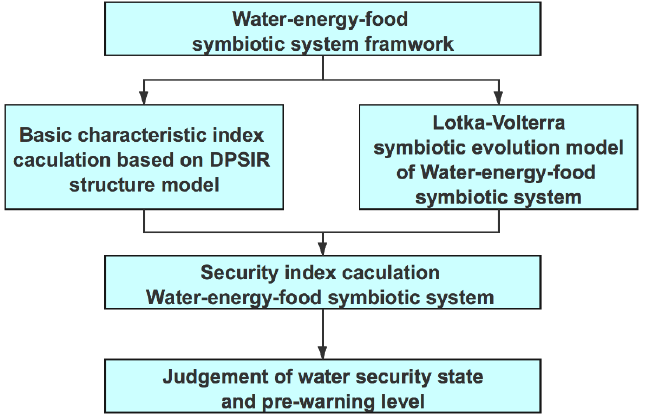
Figure 1. Flow chart of pre-warning measurement of water resources security in the Yangtze River Basin from the perspective of water-energy-food symbiosis. Note: DPSIR = driving force-pressure- state-influence-response.